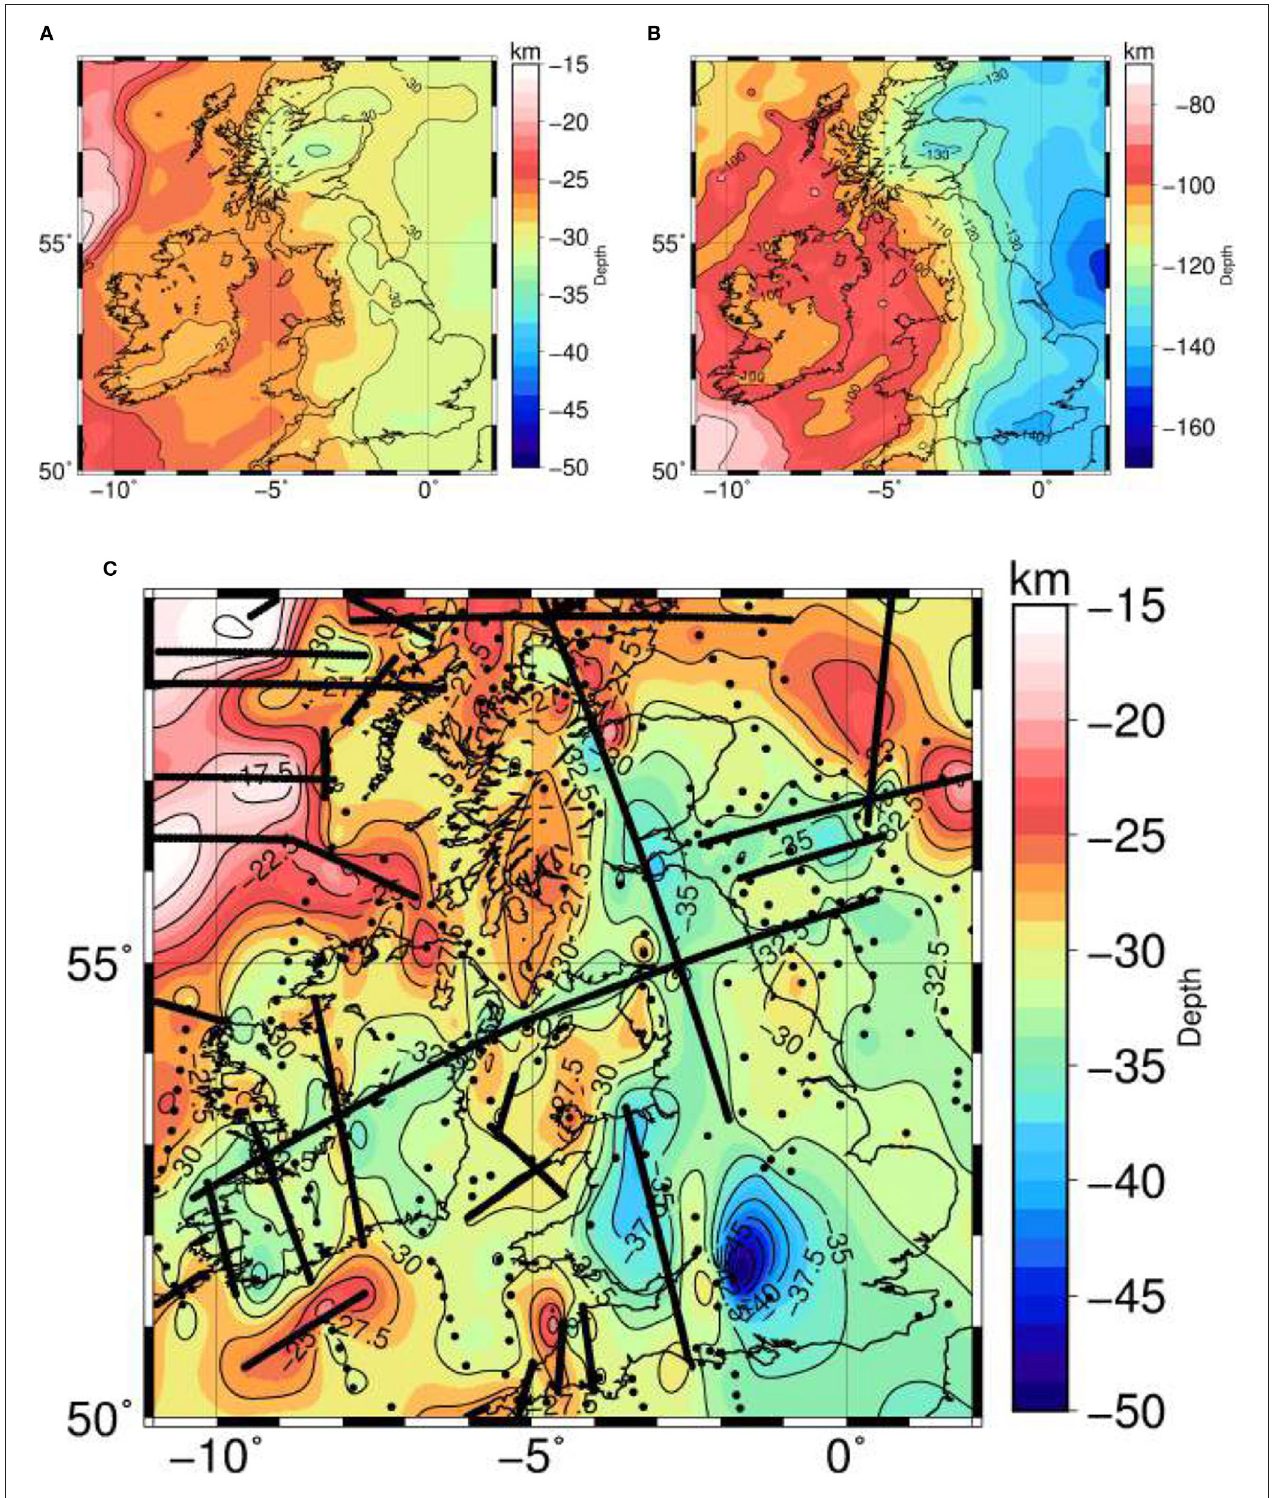
FIGURE 4 | (A) Moho and (B) Lithosphere-Asthenosphere boundary according to 1D inversion of elevation and geoid anomalies (see text for more details). (C) Moho model derived from reflection, wide angle refraction and broad band and short period receiver function seismic data (Kelly et al., 2007; Davis et al., 2012; Licciardi et al., 2014, and references therein). The location of seismic data used to define the Moho surface is shown as black lines and dots.